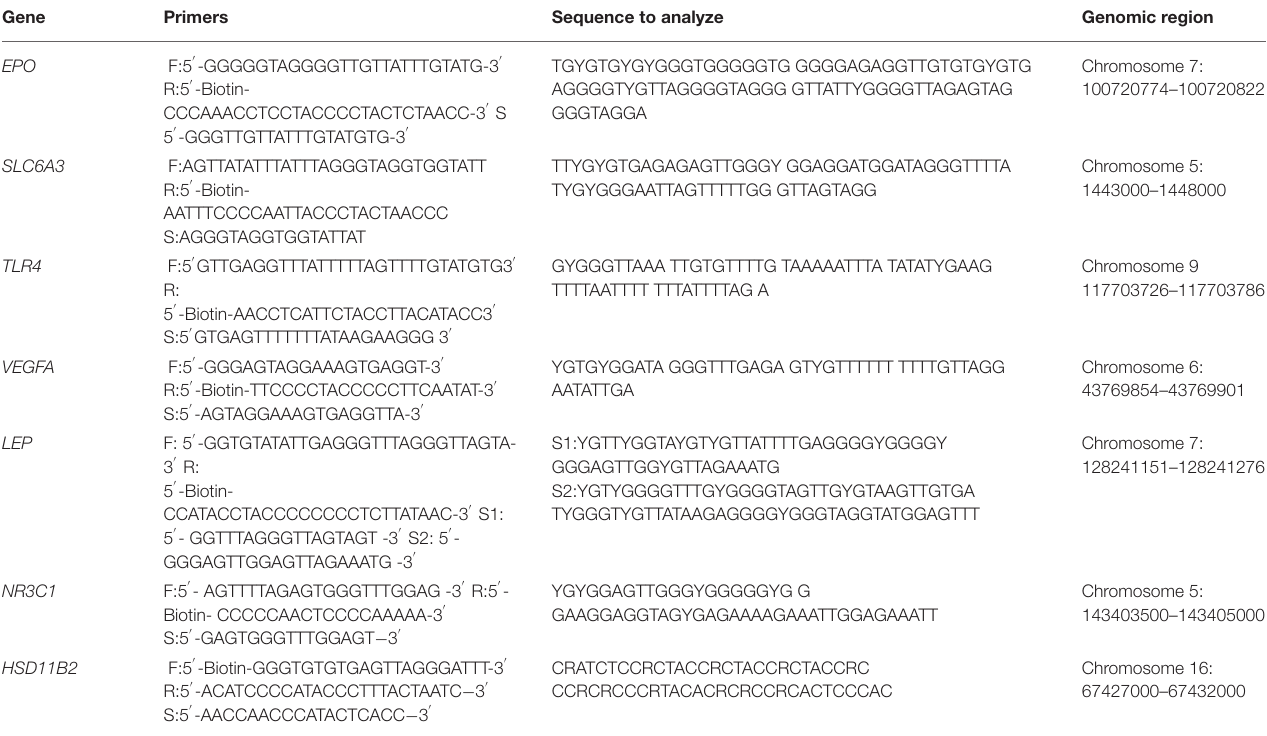
TABLE 1 | PCR forward and reverse primer sequences accompanied by sequencing primer and the sequence to analyze, and their genomic region. Gene Primers Sequence to analyze Genomic